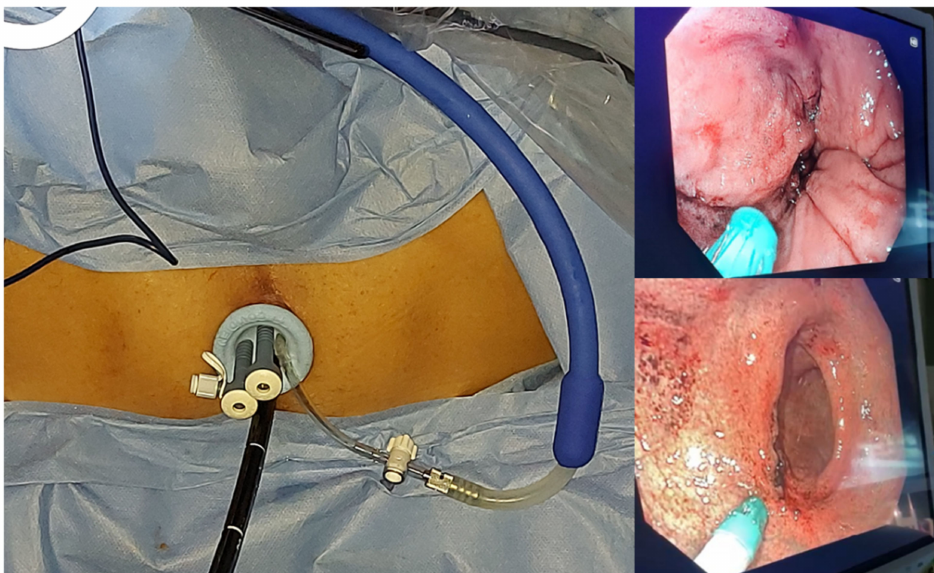
Figure 1. Trans-anal laparoscopic approach with a SILS port for ECT treatment on a lesion of the endorectal mucosa at 6 cm from the anal canal using an expandible divergent electrode with 10 degrees of divergence, a length of 20 cm, and a 5 mm shaft.